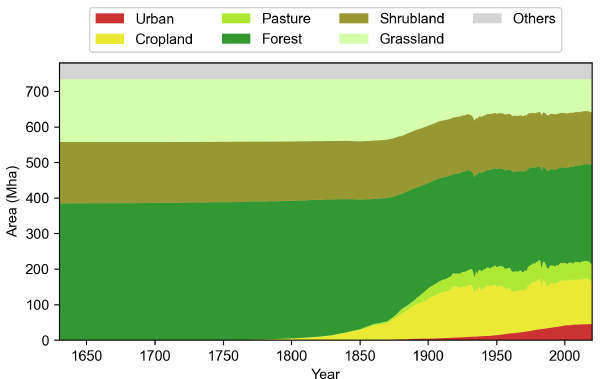
Figure 6. Land use and land cover changes in the conterminous United States from 1630 to